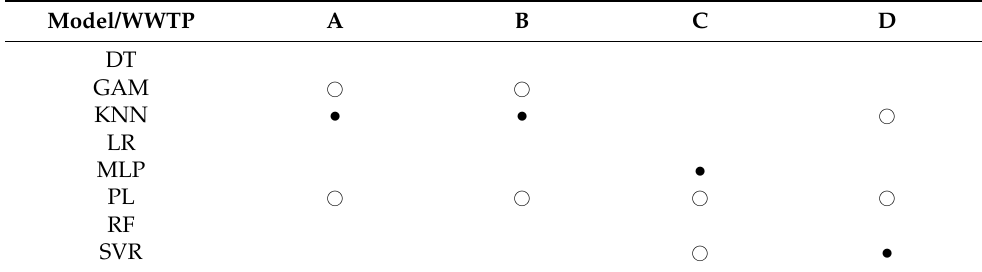
Table 4. Top ‐ three regression models for prediction in each WWTP.